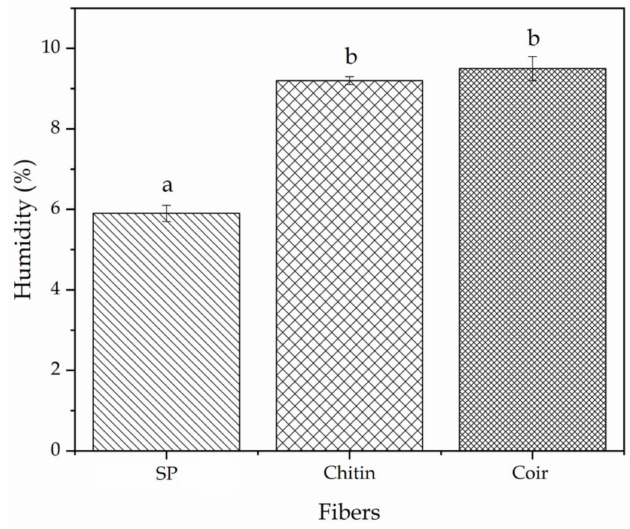
Figure 2. Percentage of moisture content (%) of soy protein (SP), chitin, and coir fibers. a,b Different letters indicate a significant difference among the samples ( p <